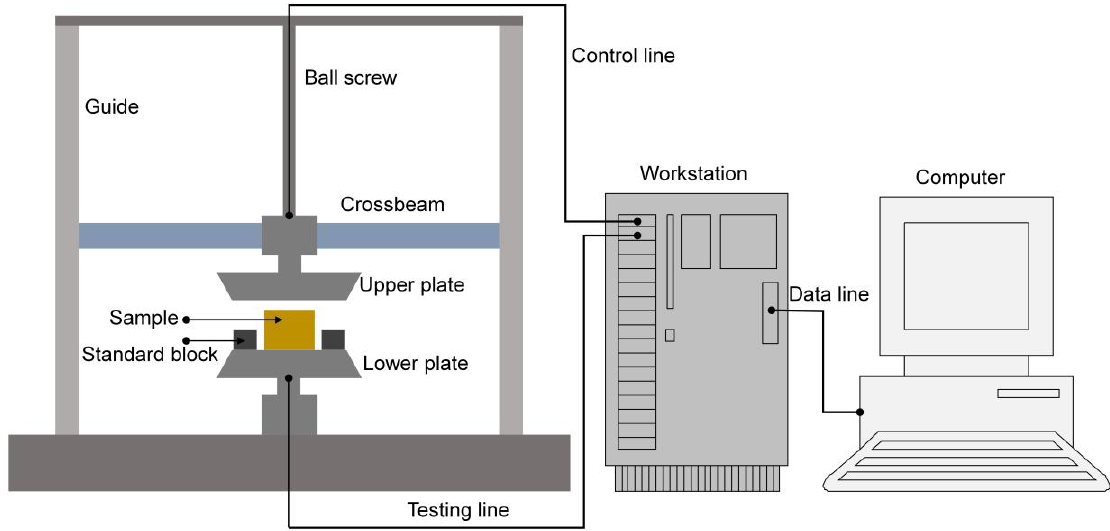
Figure 5. Schematic diagram of the used CTM2050 universal testing machine for fabrication of the optimal 10-layer gradient compressed porous metals.